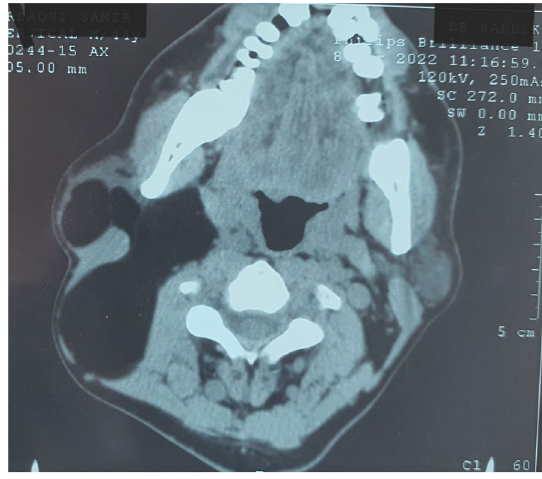
Fig. 2 Axial CT section showing the nature of the mass (lipoma), its location, and its extension